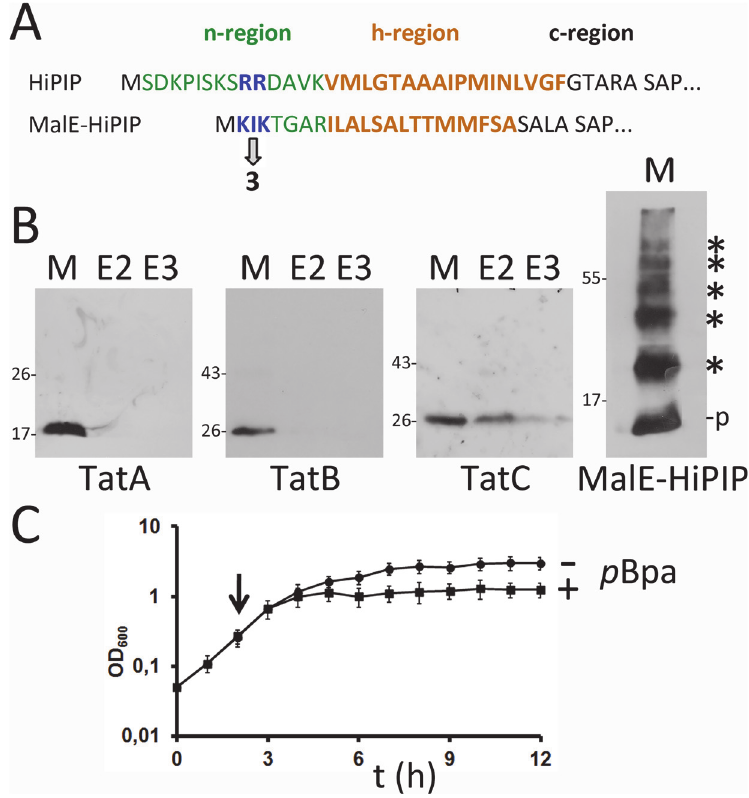
Fig 5. TatA does not cross-link to the signal peptide of the Sec substrate MalE. (A) Position of the p Bpa cross-linker in the MalE signal peptide relative to the position of the HiPIP signal peptide RR-motif. n-, h-, and c-regions are indicated (B) Cross-linking analysis of the MalE-signal peptide HiPIP fusion (expression systems and [ p Bpa] as in Fig. 1). As control, the fusion was detected in membranes by HiPIP-specific antibodies. It formed multiple cross-links with its N-terminal p Bpa, indicating full-length of the signal peptide. See text for more details. (C) Growth defect upon production of MalE-HiPIP-I3 p Bpa, pointing to jamming of the Sec translocon by Sec-targeted folded HiPIP. + p Bpa, Production of MalE-HiPIP-I3 p Bpa was induced by addition of 0.1 mM p Bpa to the growth medium at the indicated time point. - p Bpa, negative control without p Bpa